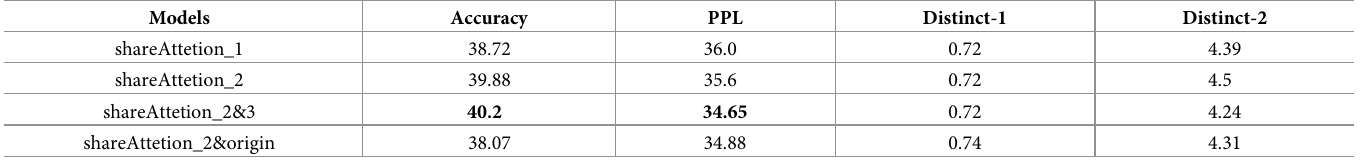
Table 3. Automatic evaluation results with different layer fusions.